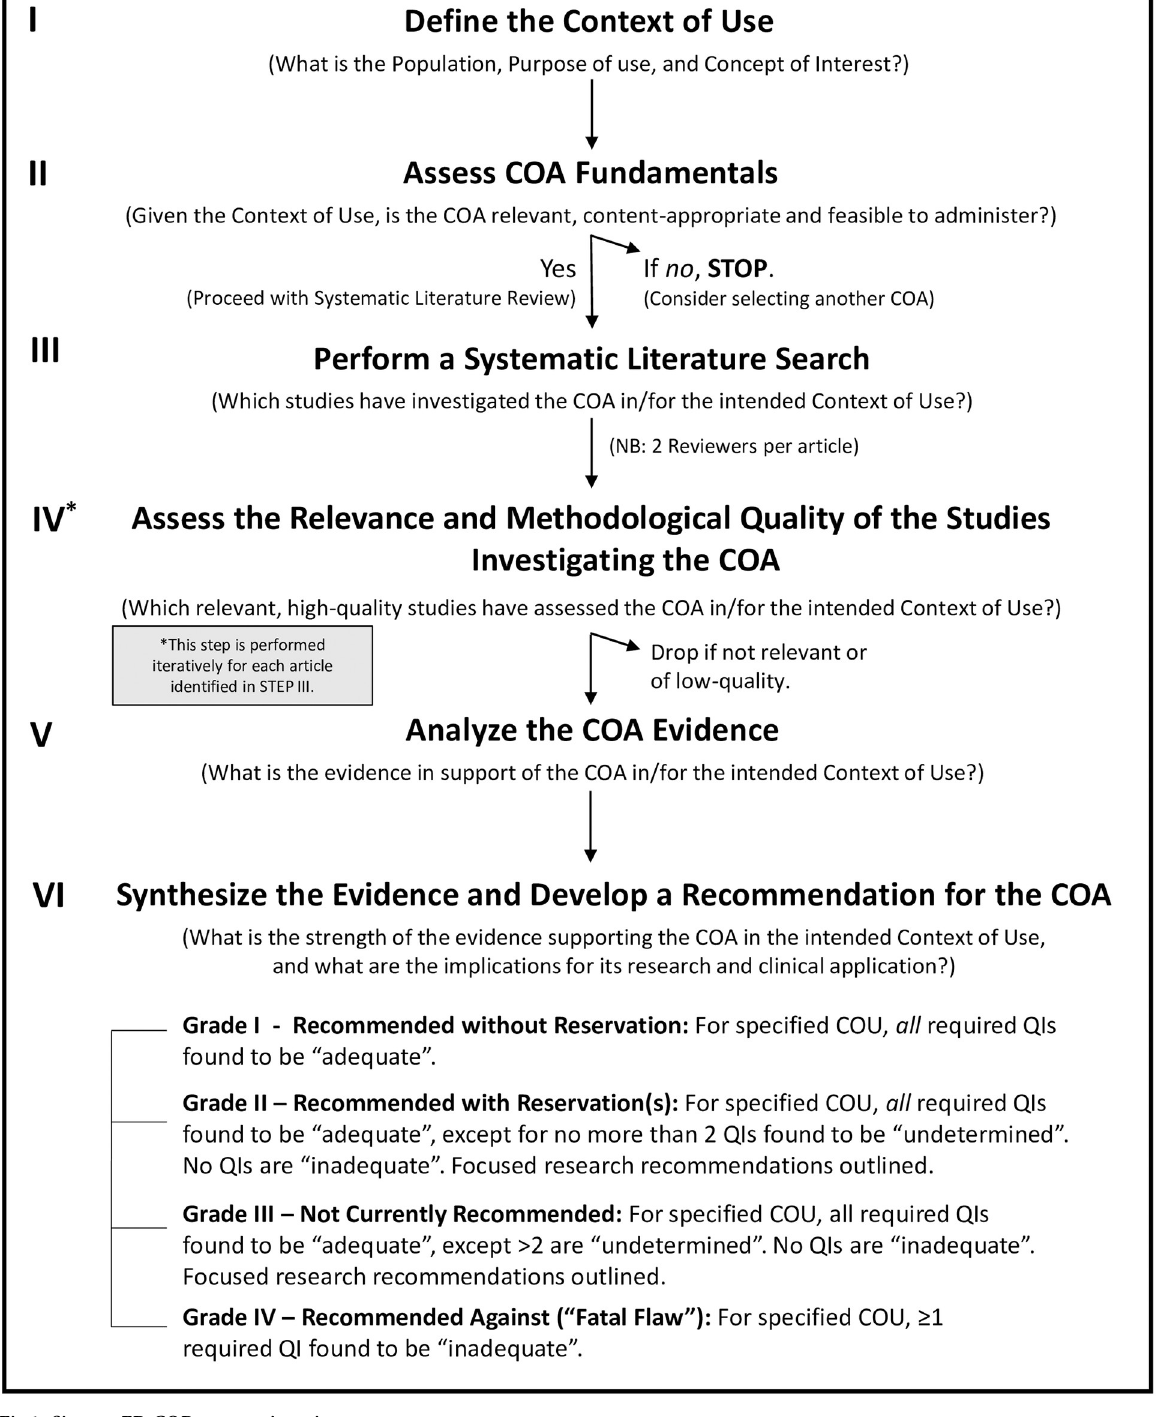
Fig 1. Six-step EB-COP systematic review process.